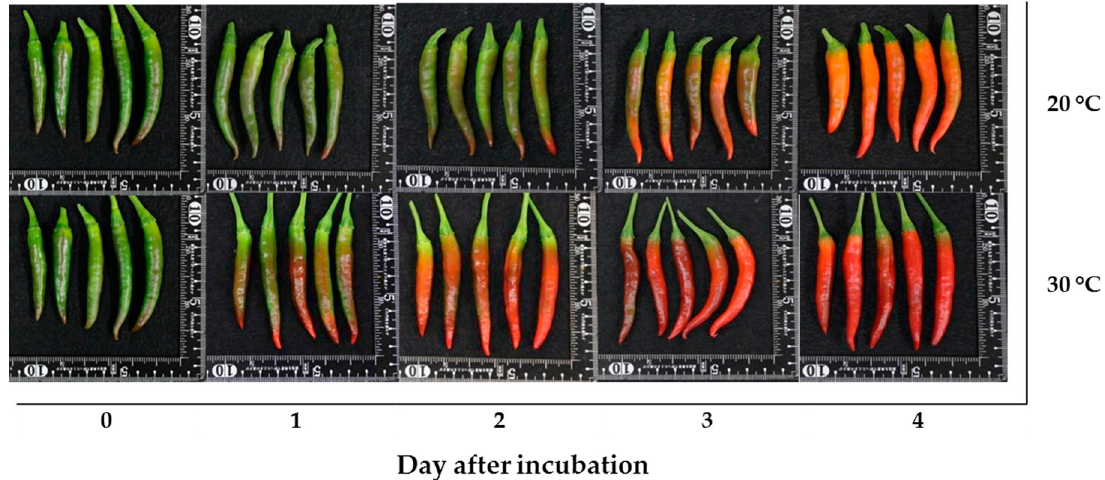
Figure 2. The appearance of “Takanotsume” chili fruit incubated at 20 and 30 °C for 4